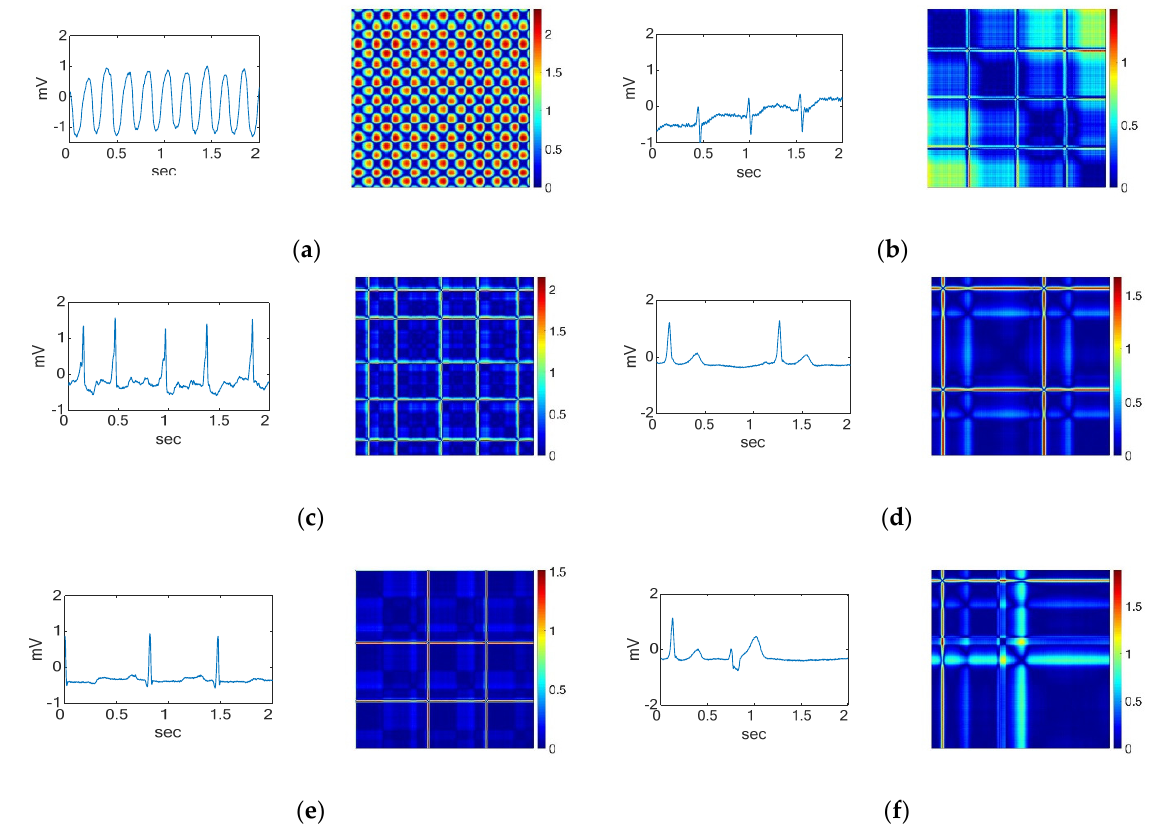
Figure 2. Waveforms and their corresponding RPs of the ( a ) VF rhythm, ( b ) noise, and the other four ECG arrhythmia types which need further classification including ( c ) AF, ( d ) normal, ( e ) PAC, and ( f ) PVC.